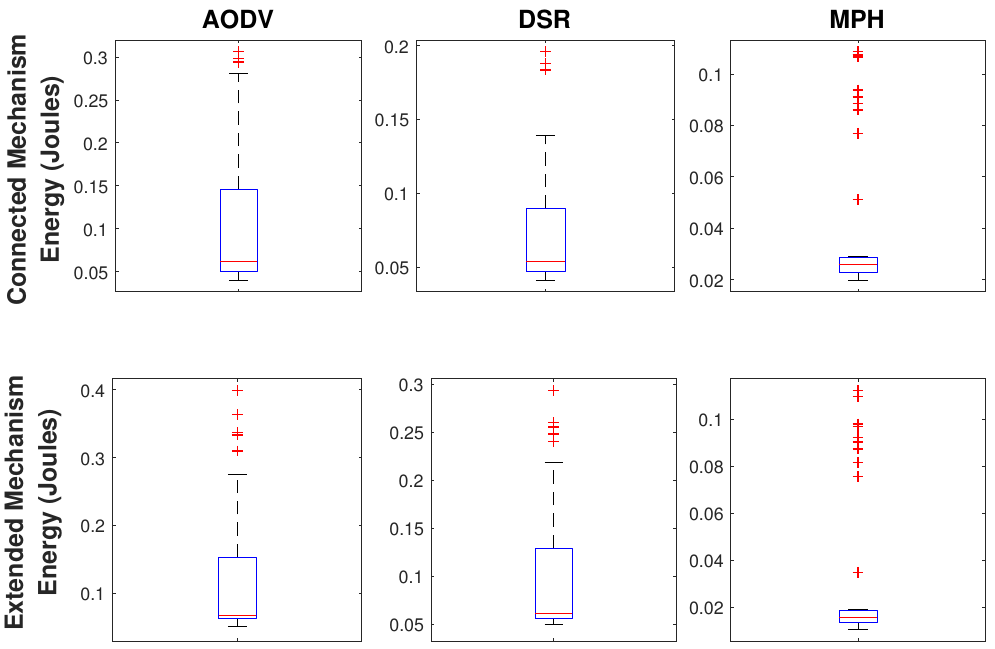
Figure 10. Comparison of energy distribution for AODV, DSR, and MPH protocols under Scenario